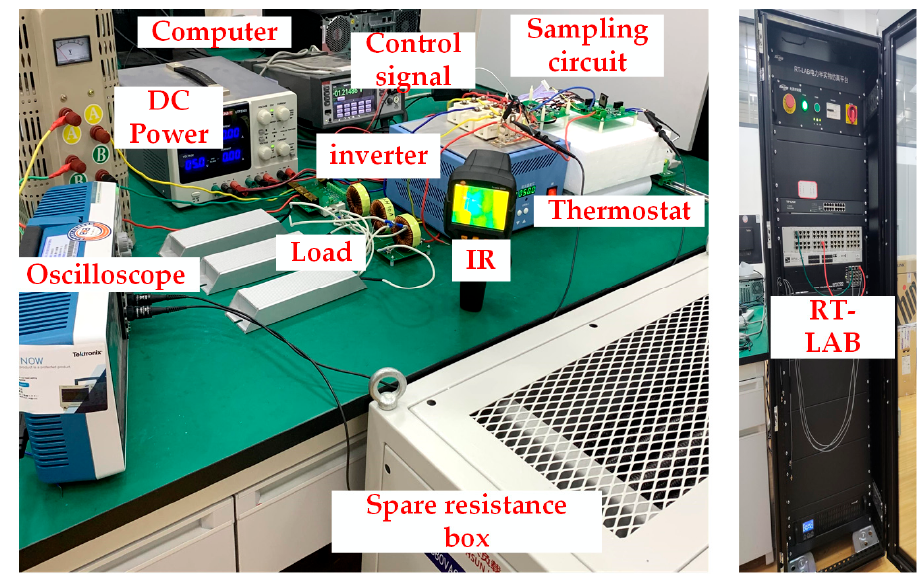
Figure 5. Aging monitoring platform.